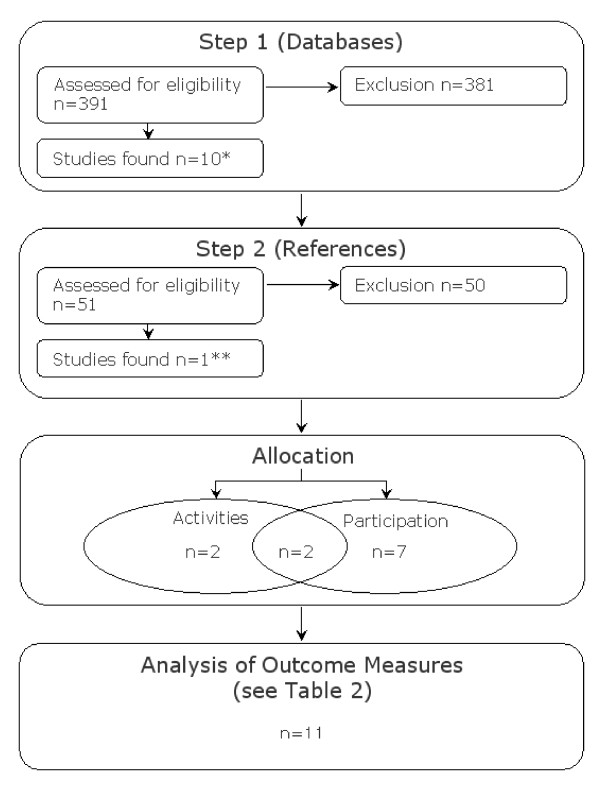
Process of Selection. * Studies include references [23,29-32,38,39,41,42]. ** Studies include references [28].